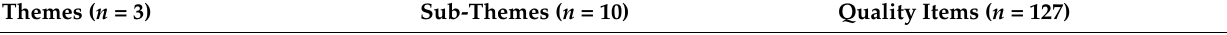
Traditional community pharmacy